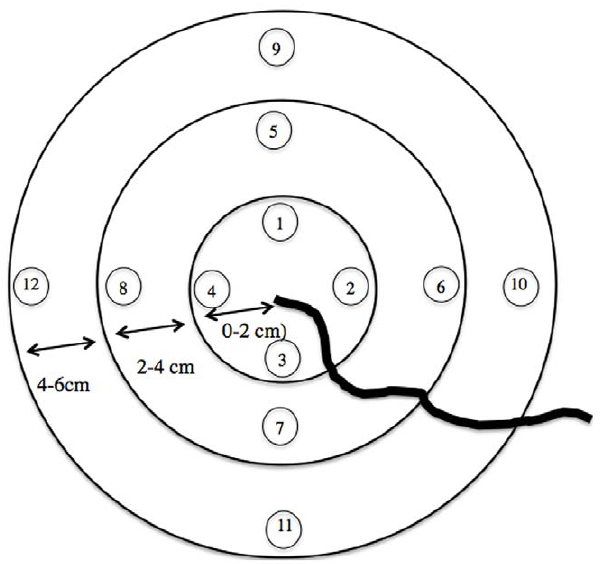
Figure 1. Drawing showing areas where samples were taken from in each individual placenta.